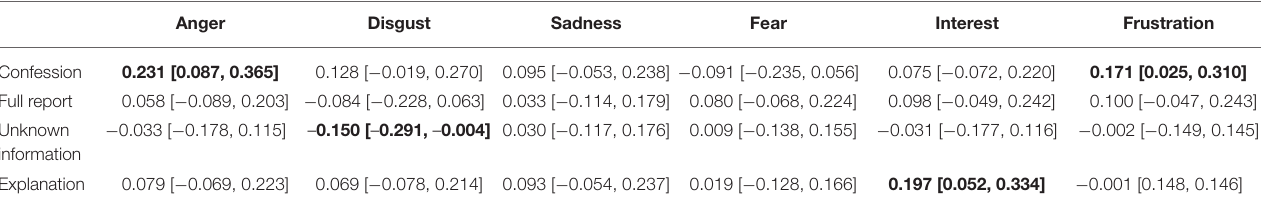
TABLE 6 | Bivariate correlations and 95% confidence intervals of emotion composites and interview